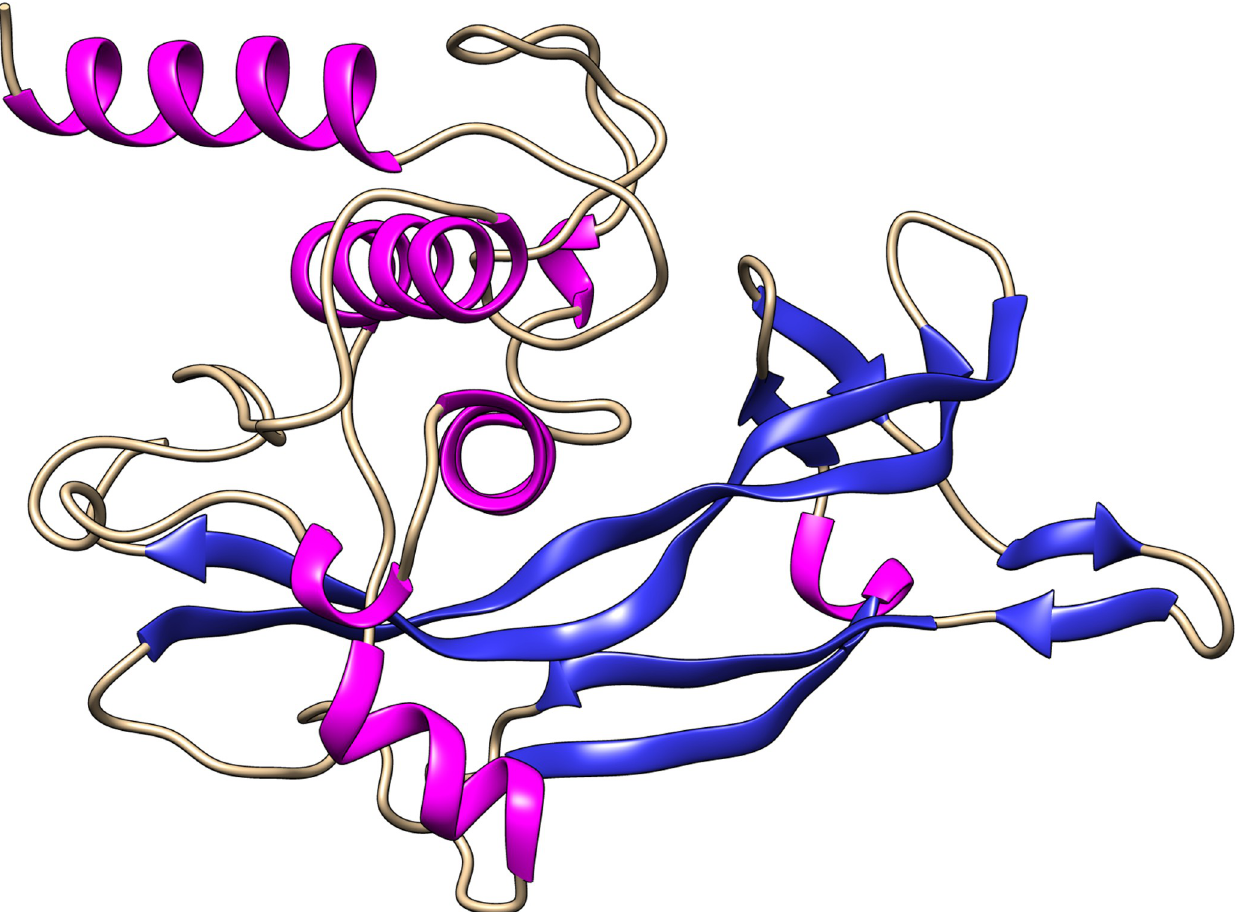
Fig 1. In silico modeled structure of BDNF by Rosetta. Secondary structure representation of the in silico modeled structure of BDNF generated by Rosetta. The α -helices are represented by pink ribbons, the β -strands are represented by blue arrows, and the coiled regions are represented in beige.